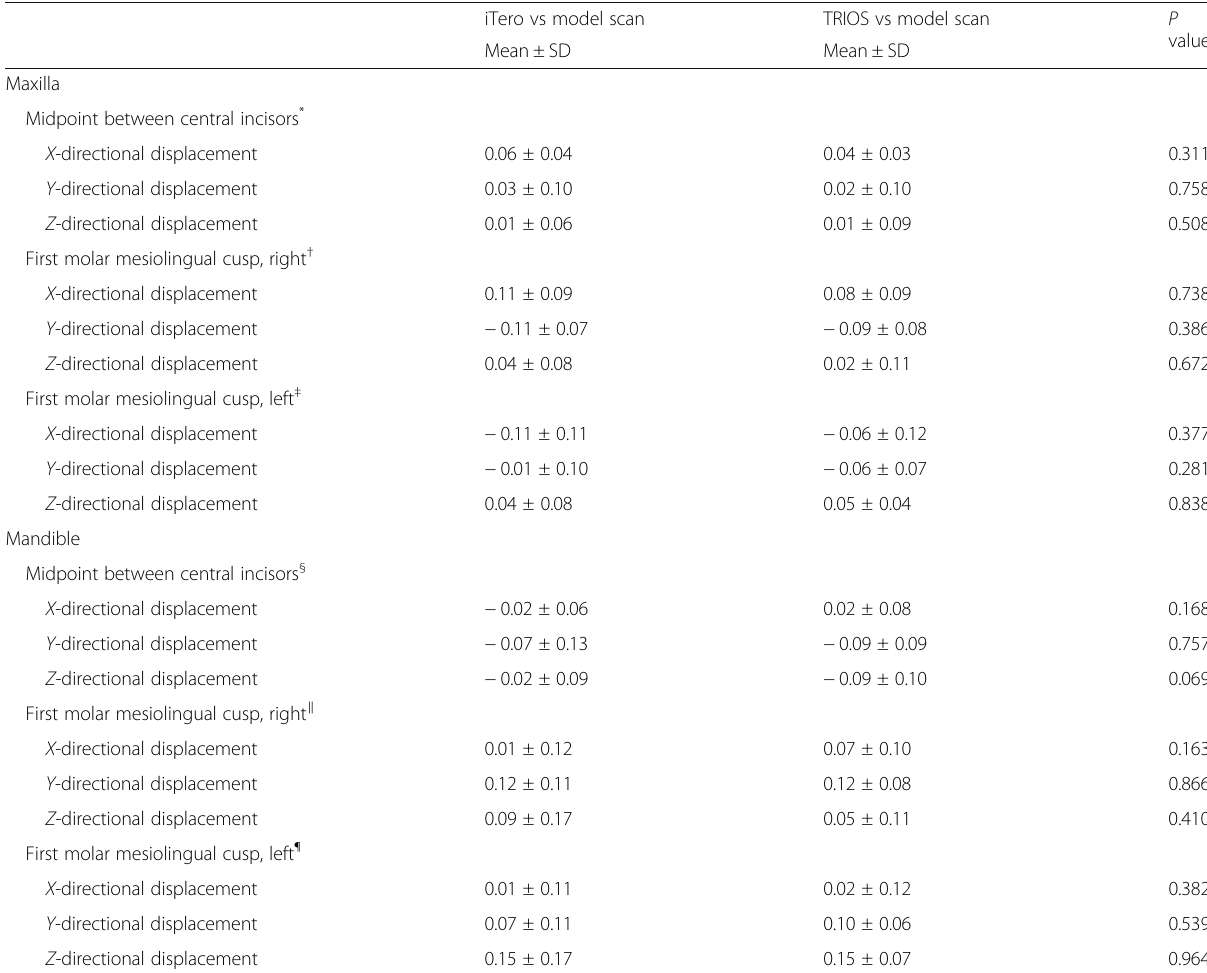
Table 3 Three-dimensional discrepancy between each intraoral scan and model in the incisor and molar regions and its comparison between the iTero and TRIOS scanners (unit: